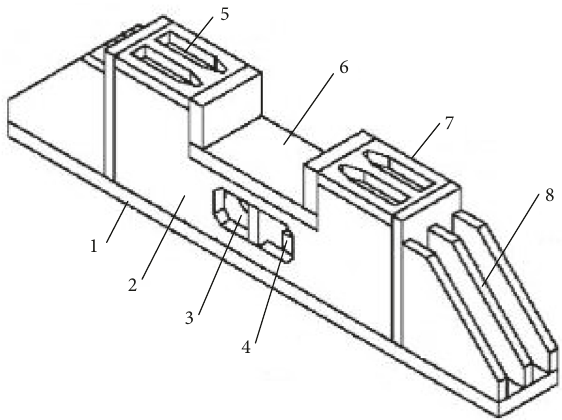
Figure 3: The support entity of experiment.1. Support bottom plate, 2. support front plate, 3. air inlet, 4. cooling fin, 5. air outlet, 6. heating area, 7. support back plate, and 8. rib plate.